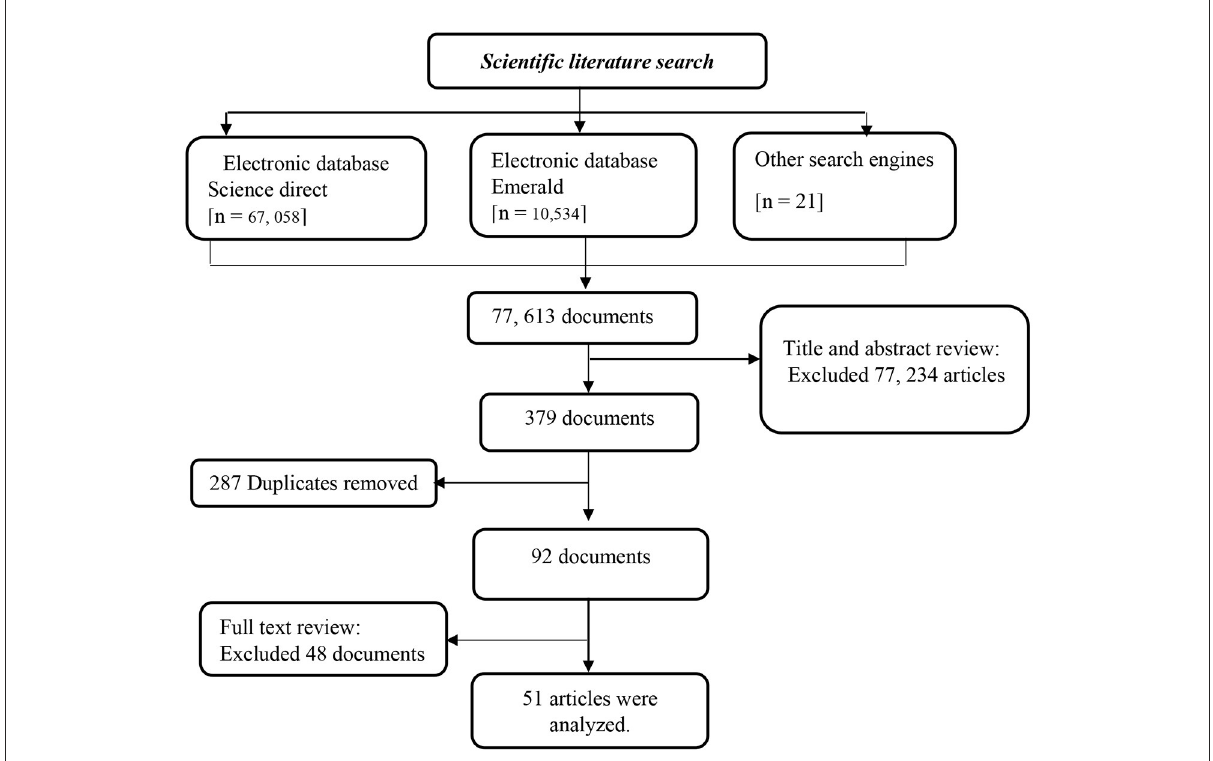
FIGURE1 Flowchart for the selection of studies.